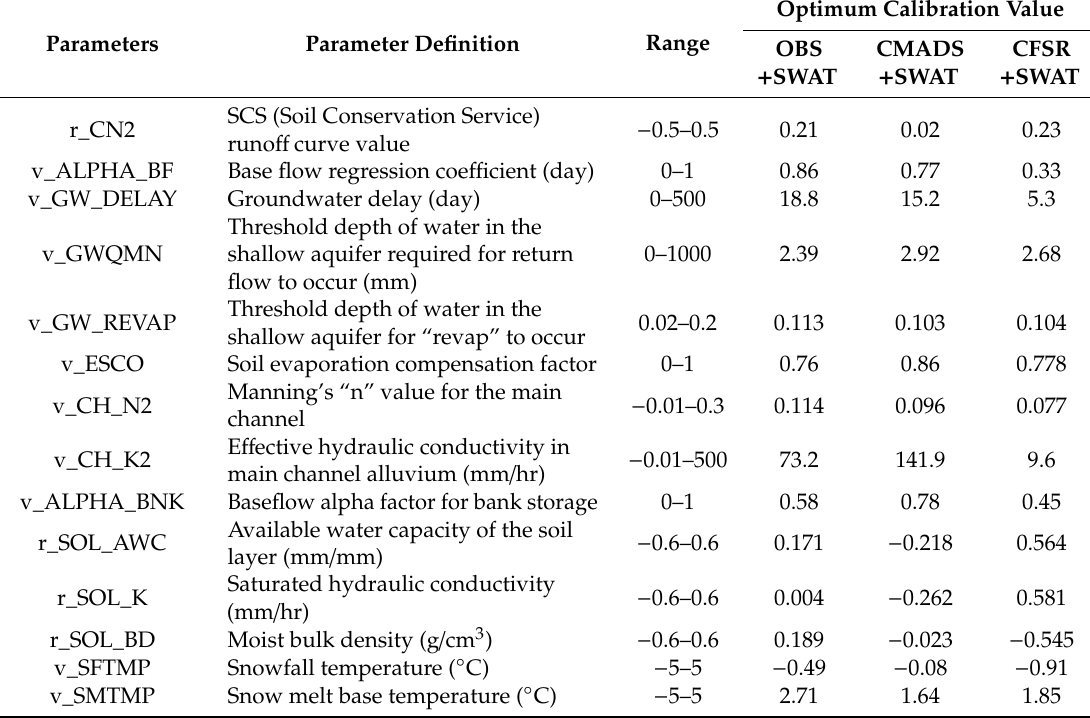
Table 2. The parameters and their fitted values of the Soil and Water Assessment Tool (SWAT) model in the Hunhe River